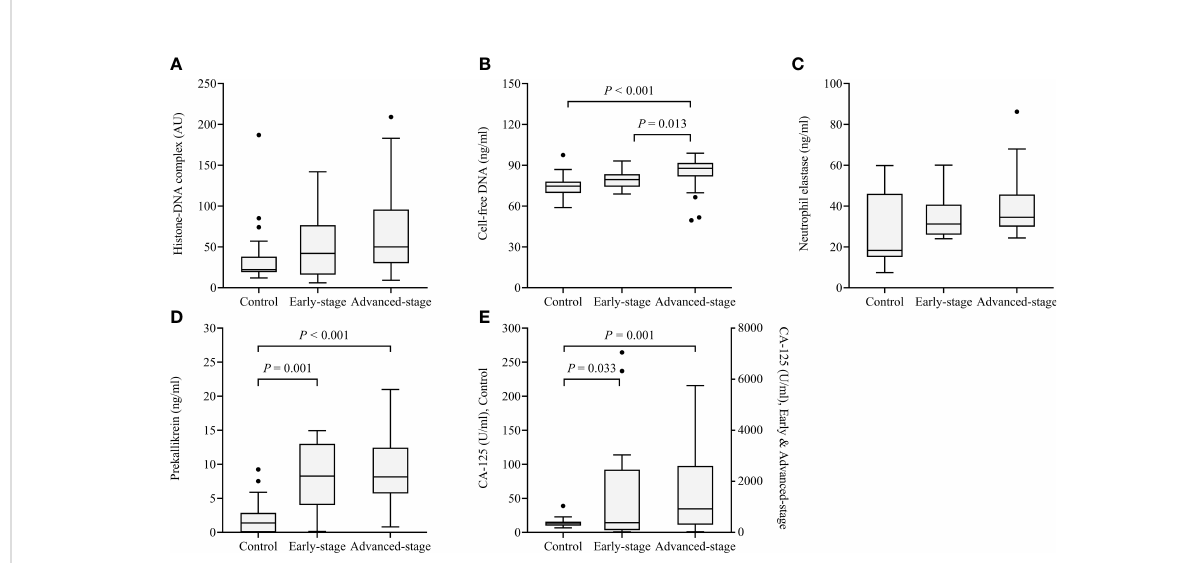
FIGURE 2 Box and whisker plots of the levels of the four markers in healthy controls (n = 23) as well as patients with early-stage (n = 17) and advanced- stage high-grade serous ovarian cancer (n=58). (A) Histone − DNA complex; (B) Cell-free DNA; (C) Neutrophil elastase; (D) Prekallikrein; (E) CA- 125. The median, range (whiskers), and 25 th to 75 th percentile (box) are shown.